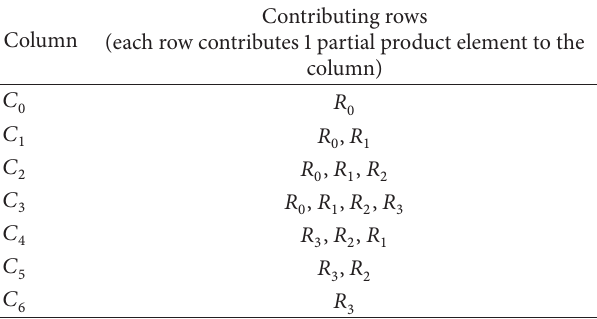
Table 3: Contributing rows for different columns for 4-bit variable multiplied by 4-bit constant.